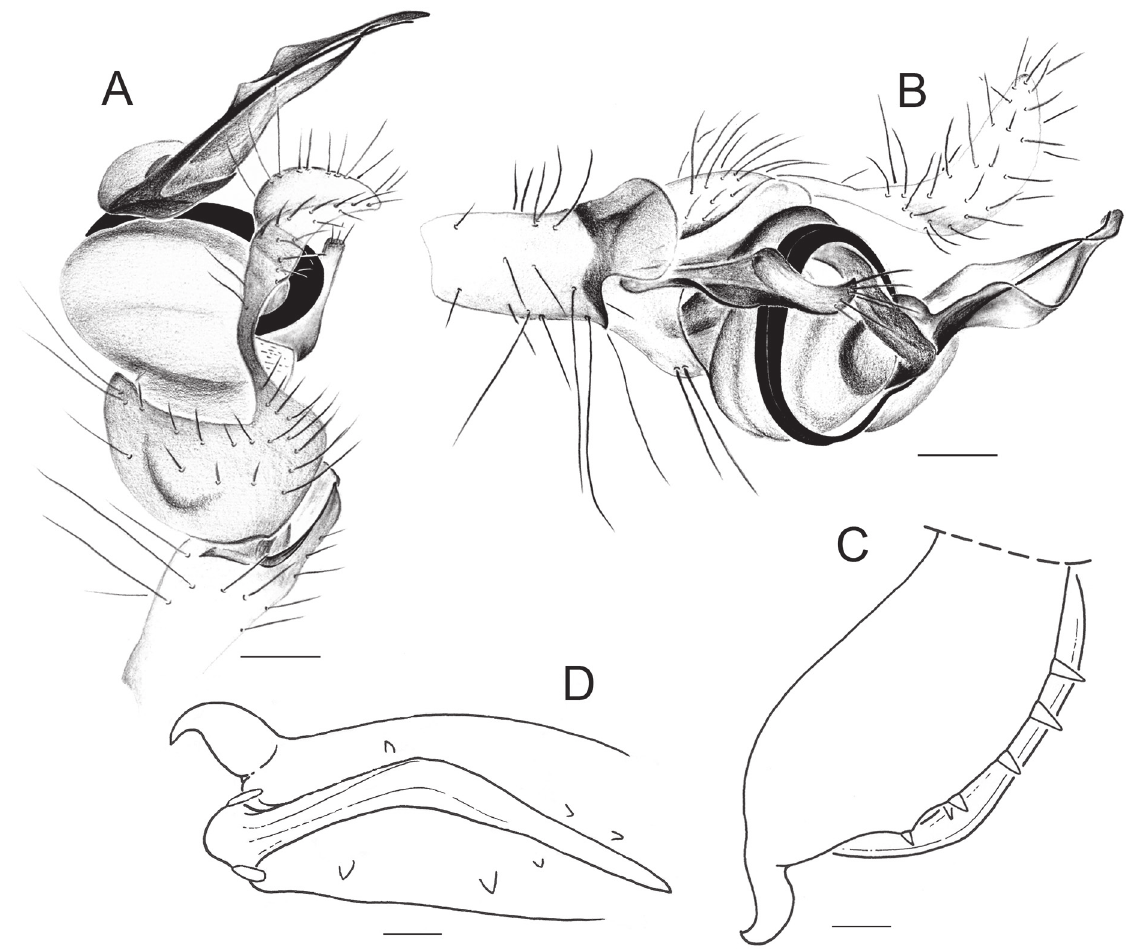
Fig. 2. Pachygnatha bispiralis sp. nov. A . Male left palp, dorsal view. B . Male palp, retrolateral view. C . Male right chelicera, frontal view. D . Male right chelicera, ventral view. Scale bars = 0.1